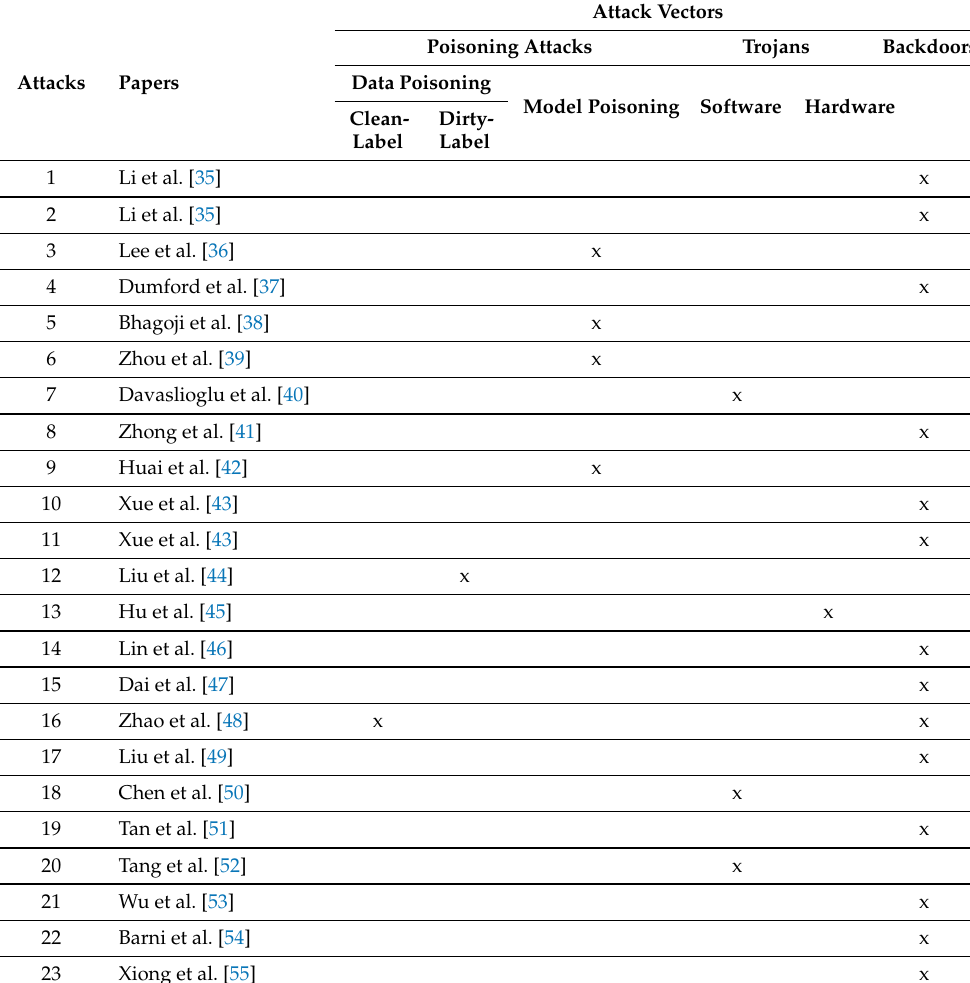
Table 8. A summary of attack vectors for each